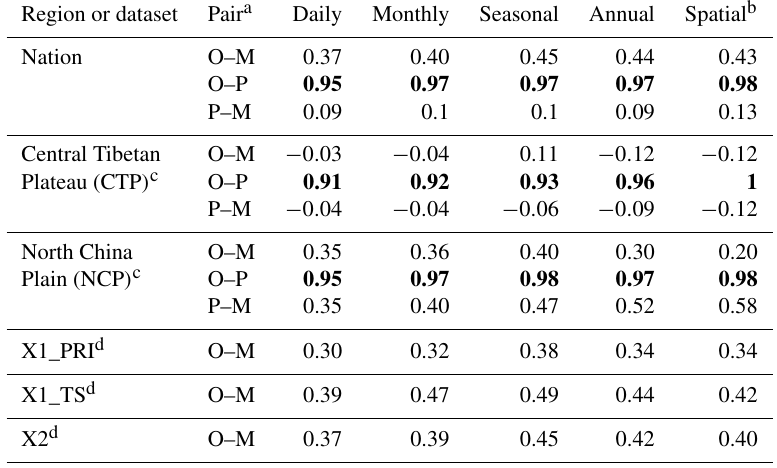
Fig. 1 for the locations of the CTP and the NCP. d X1_PRI: nationwide a priori information for MOPITT CO; X1_TS: nationwide MOPITT CO processed with the temporal and spatial convolution; X2: nationwide nighttime MOPITT CO; and all the other MOPITT CO data refer to daytime